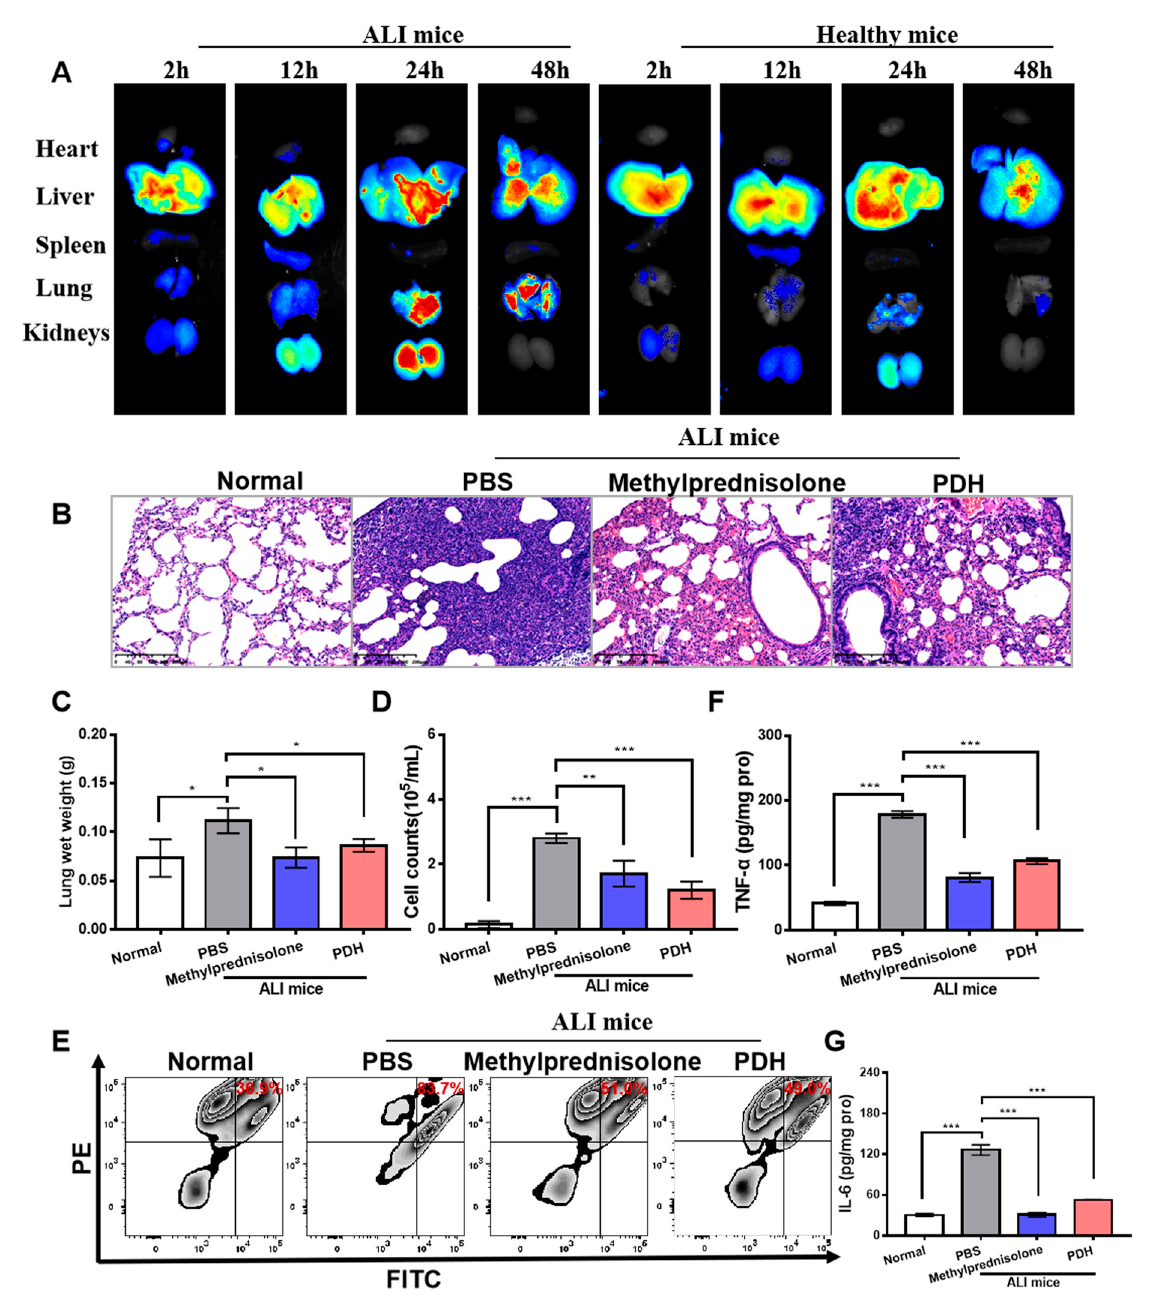
Figure 4. In vivo therapeutic effect of PDH nanoparticles on ALI-induced mice. ( A ) Biodistribution of PDH/ICG in vivo. The fluorescence images of harvested organs from mice treated with LPS or not at 2 h, 12 h, 24 h and 48 h. ( B ) Morphologic alterations in lungs after different treatments were identified by hematoxylin and eosin staining. Scale bar = 200 μ m. ( C ) The lung wet weight. ( D ) The total cell counts in the bronchoalveolar lavage fluid detected by flow cytometry. ( E ) The neutrophil counts in the bronchoalveolar lavage fluid measured by flow cytometry. ( F ) The level of TNF- α in lung tissues detected by TNF- α ELISA kit. ( G ) The level of IL-6 in lung tissues detected by IL-6 ELISA kit. (* p < 0.05, ** p < 0.01, *** p < 0.001, n = 3).